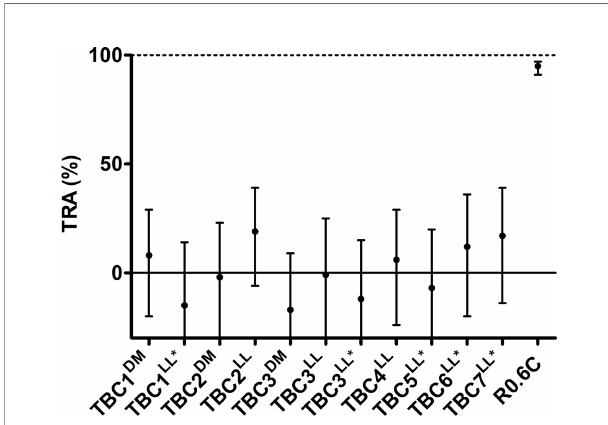
FIGURE 5 | IgGs from mice immunized with novel transmission blocking vaccine candidates do not reduce transmission. Puri fi ed IgGs were tested in a single standard membrane feeding assay at a fi nal concentration of 750 µg/ mL except for TBC1 LL * and TBC3 LL *, they were tested at 540 and 590 µg/ mL due to low IgG yield, respectively. Transmission reducing activity (% TRA) estimates are shown with 95% con fi dence intervals. R0.6C showed statistical signi fi cant TRA (p<0.001), while none of the other groups showed signi fi cant TRA. Names with * indicate antigens that were expressed as R0 chimeras. Note that for TBC7 LL * only 17 mosquitoes had